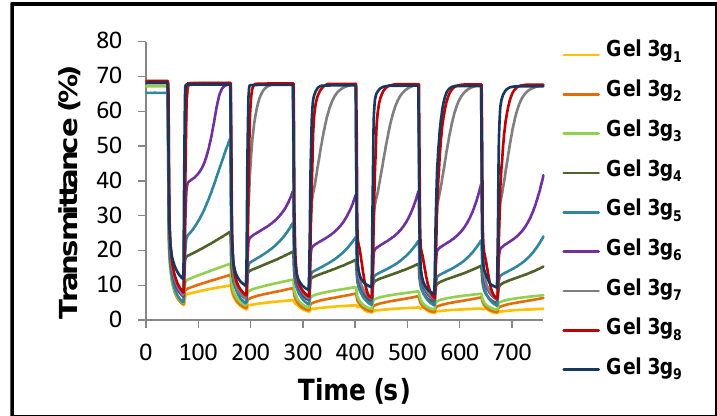
Figure 10. Transmittance changes at the maximum contrast wavelength (550 nm) of ECDs based on gels 3g 1–9 comprising different amounts of redox pairs (ferro/ferricyanide salts, from 0.4 for 3g 1 to 6.0 mmol L −1 for 3g 9 ) while potential steps between bleached (0 V for 90 s) and colored states (−2.3 V for 30 s) were being applied. Reprinted with permission from [126], copyright (2015) John Wiley and Sons, Inc.